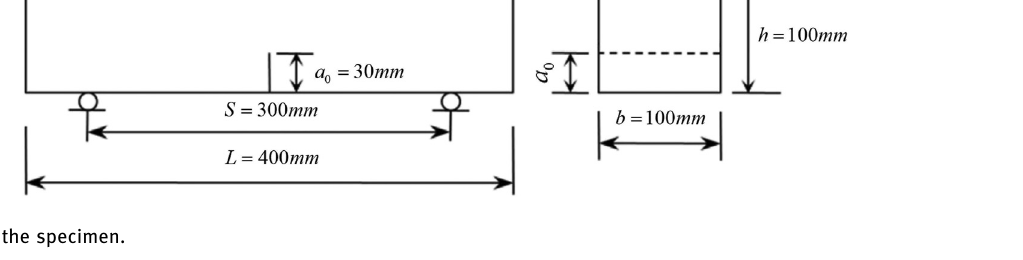
Figure 4: Shape of the specimen.